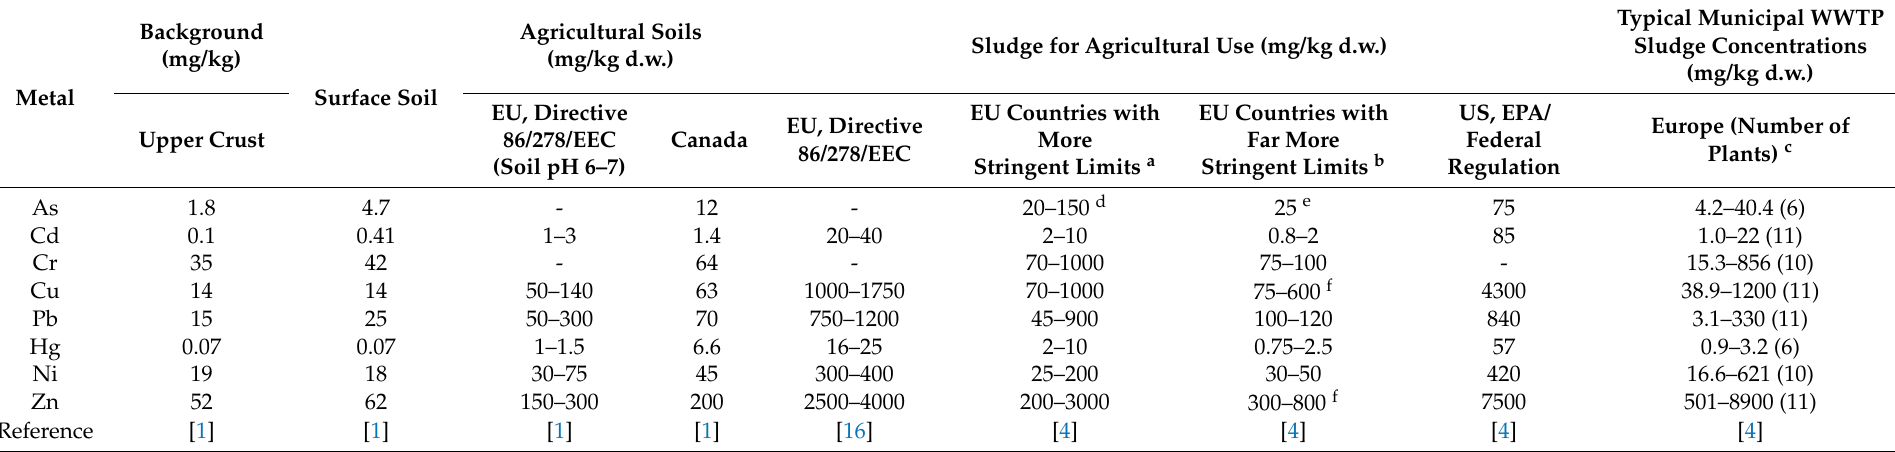
Table 2. Heavy metal concentrations in municipal WWTP sludge compared to natural soil (background), and limit values in agricultural soils (EU/Canada) and in sludge (EU/US